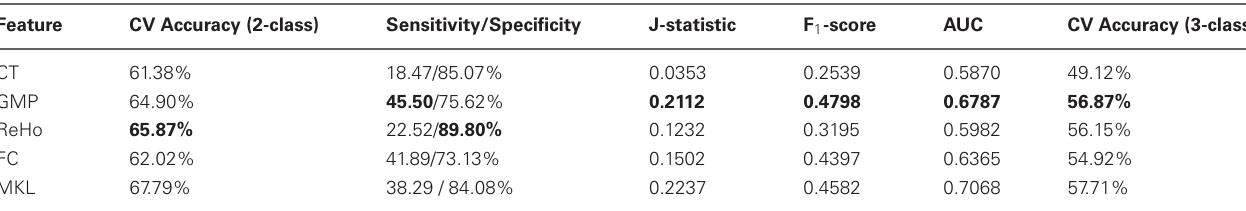
Table 3 | The 10-fold CV classification results using a single kind of feature and multimodal features.